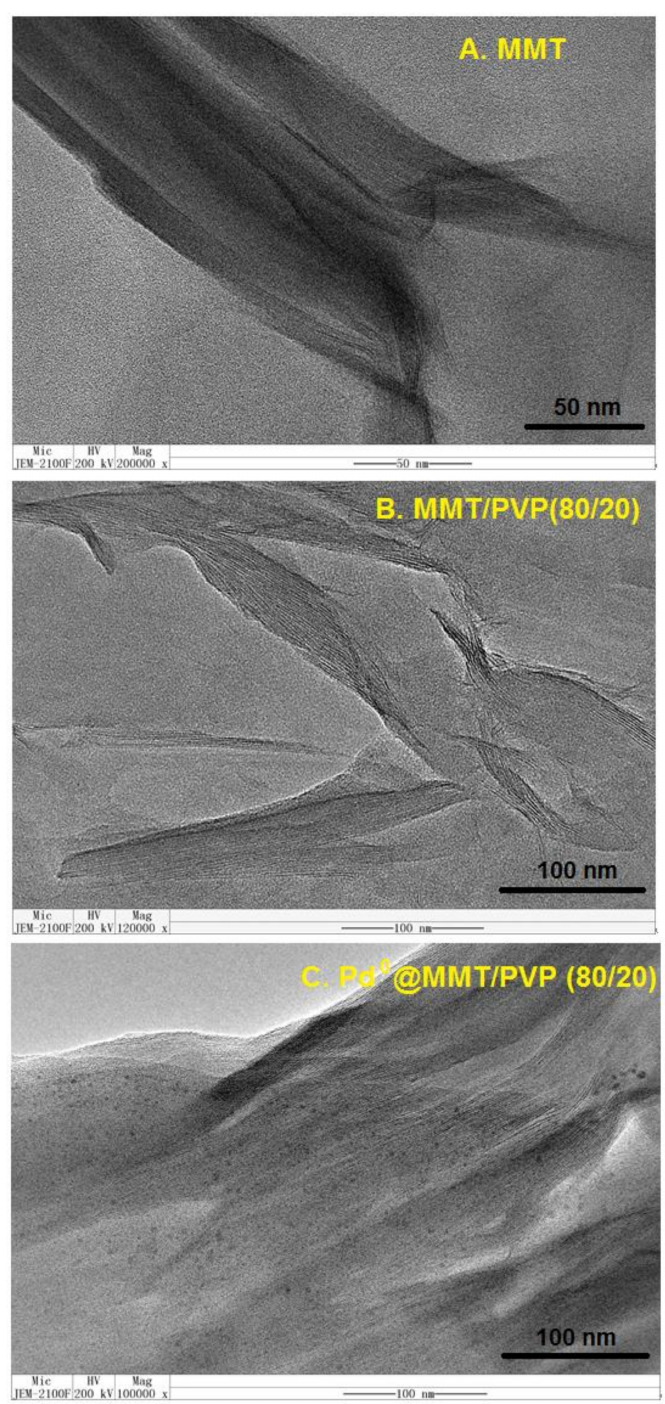
Figure 3. HR-TEM images of MMT ( A ), MMT/PVP support ( B ) and Pd@MMT/PVP catalytic composite ( C